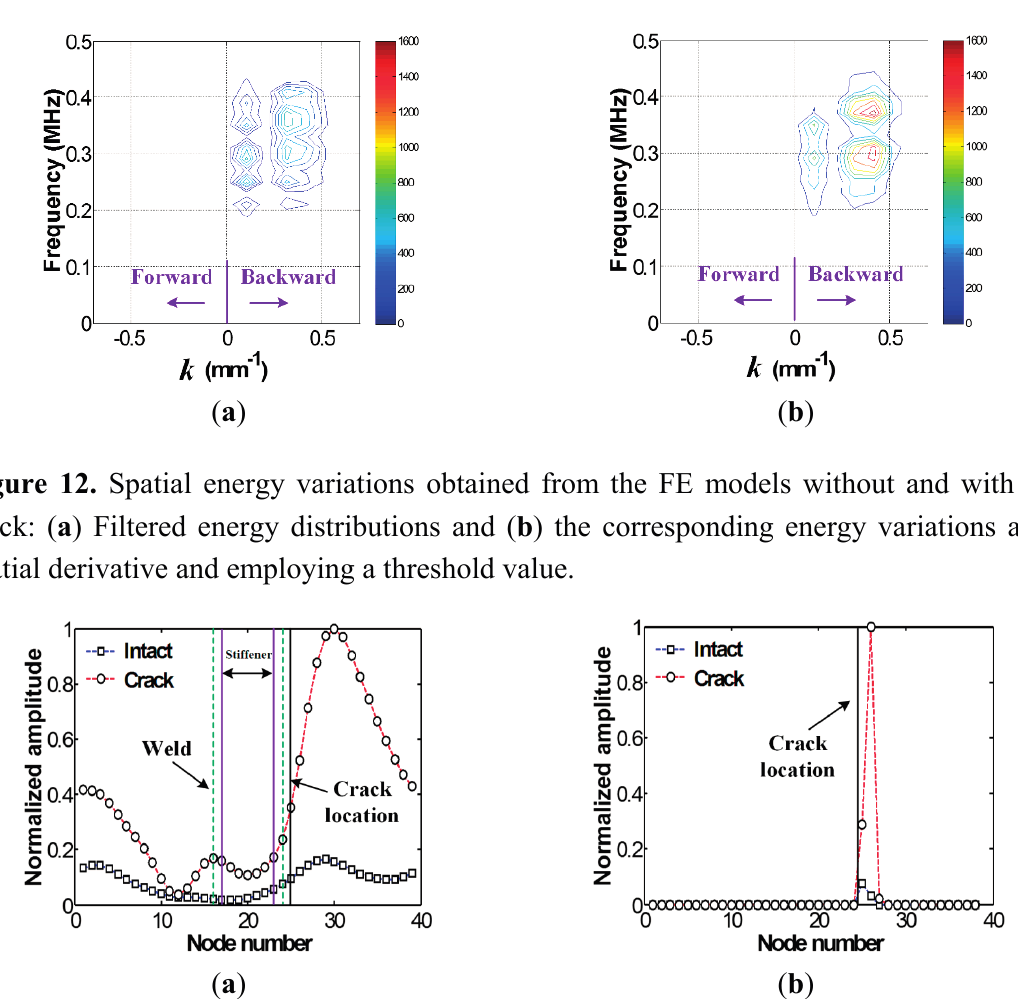
Figure 11. Filtered f-k domain plots obtained from the FE models ( a ) without and ( b ) with the crack.